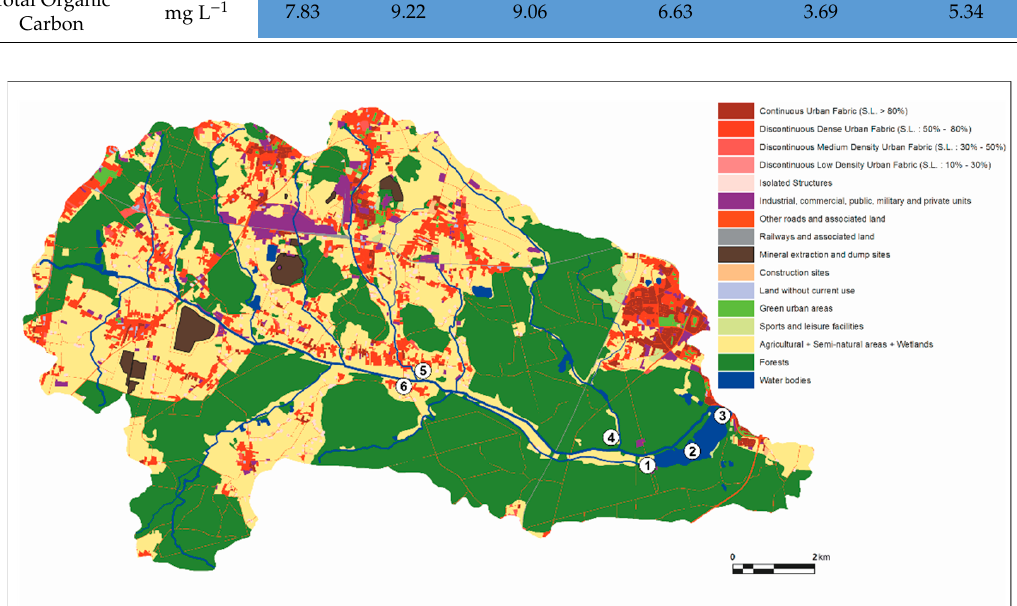
Figure 5. Land cover of the Paprocany reservoir catchment area developed on the Urban Atlas 2012 basis. The number in the white circles shown localization of points of water analysis. In the central part of the reservoir, there are areas with lower water temperature. This may Table 7. Classification of water quality in the Paprocany reservoir and the catchment of the indicate a natural groundwater inflow in this area of the reservoir. However, the observed changes are water (analyses based on the data provided by the City of Tychy, the Regional Inspectorate of Environmental Protection in Katowice and by authors’ analyses)